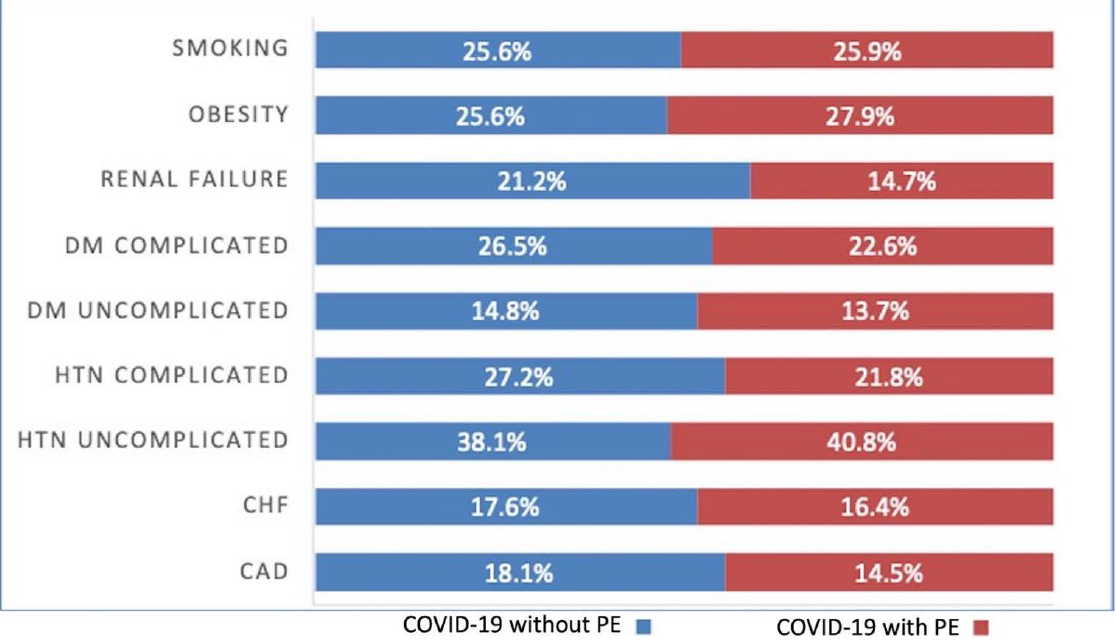
Table 2. Patients with COVID-19 with and without pulmonary embolism propensity 1:1 matched patient-level characteristics. Characteristics